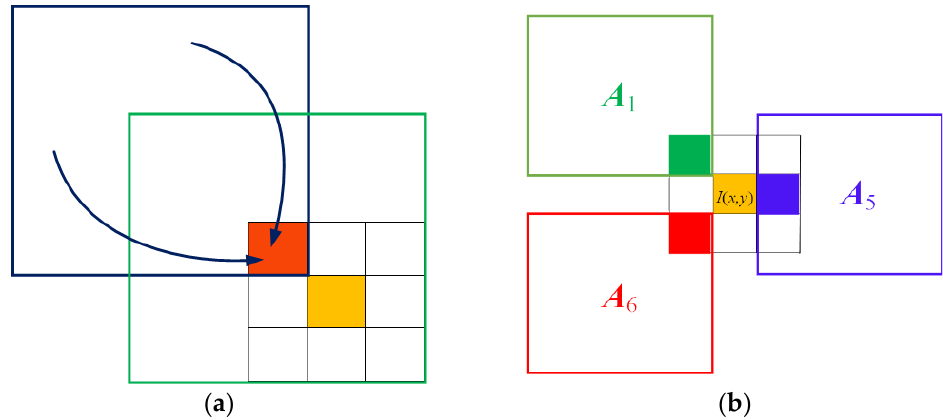
Figure 3. The action position of Gaussian function. ( a ) is difference between the region of our information fusion and the region of Gaussian filtering, ( b ) is the diagram of generating the redefined pixels